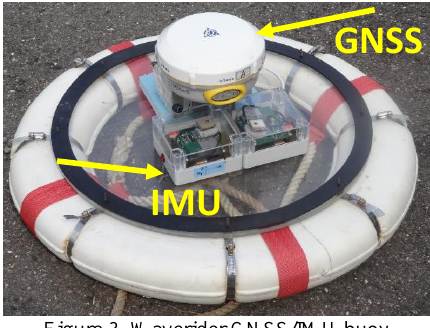
Figure 3. Waverider GNSS/IMU buoy